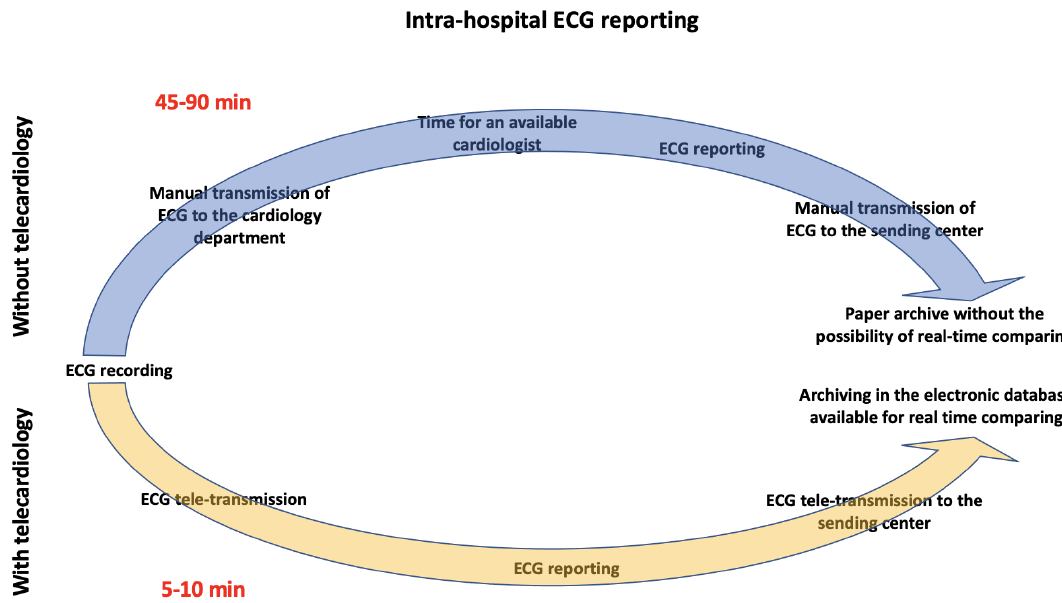
Figure 3. The different paths of the intra-hospital ECG with and without telecardiology.